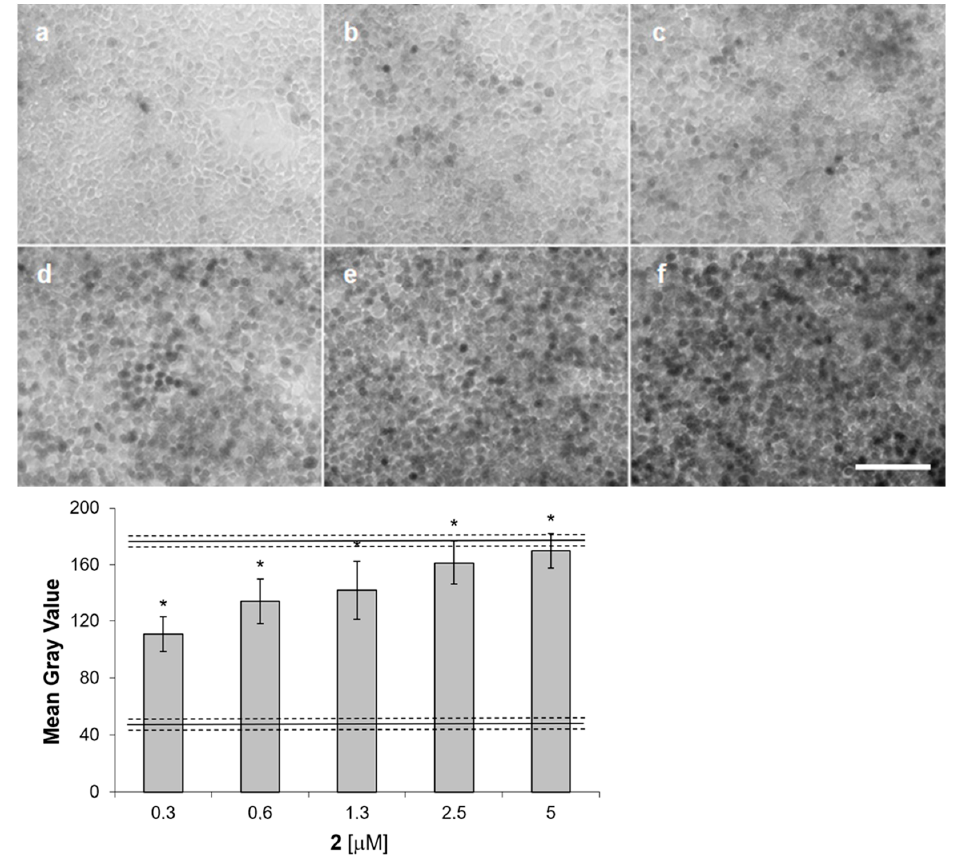
Figure 2. F9 RARE- lacZ reporter cells show concentration-dependent activation upon treatment with 2 for 20 h. Top: bright-field images of cells treated with 2 (( a ): 0 µM, ( b ): 0.3 µM, ( c ): 0.6 µM, ( d ): 1.3 µM, ( e ): 2.5 µM, ( f ): 5.0 µM), and β -galactosidase activity was visualized by X-Gal staining (scale bar: 100 µm). Bottom: densitometric image analyses (mean ± SD); a greater gray value means stronger RARE binding. The threshold lines at 45 and 175 represent the control and the effect of 10 nM all- trans retinoic acid. * p < 0.001, Student’s t test, groups treated with 2 were compared to con- trol, n = 5.